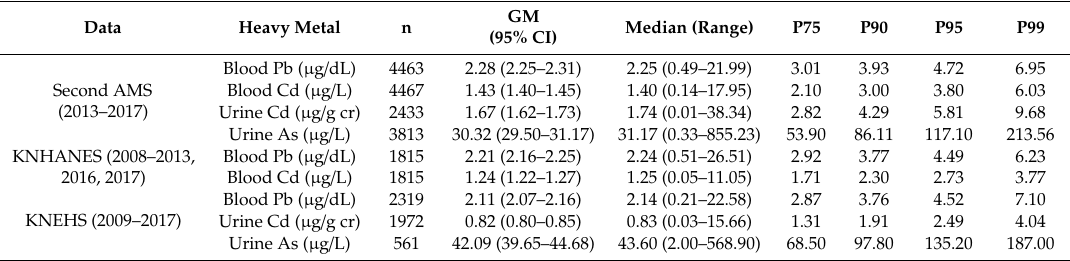
Table 1. Distribution of the blood lead (Pb), cadmium (Cd), urine Cd, and arsenic (As)